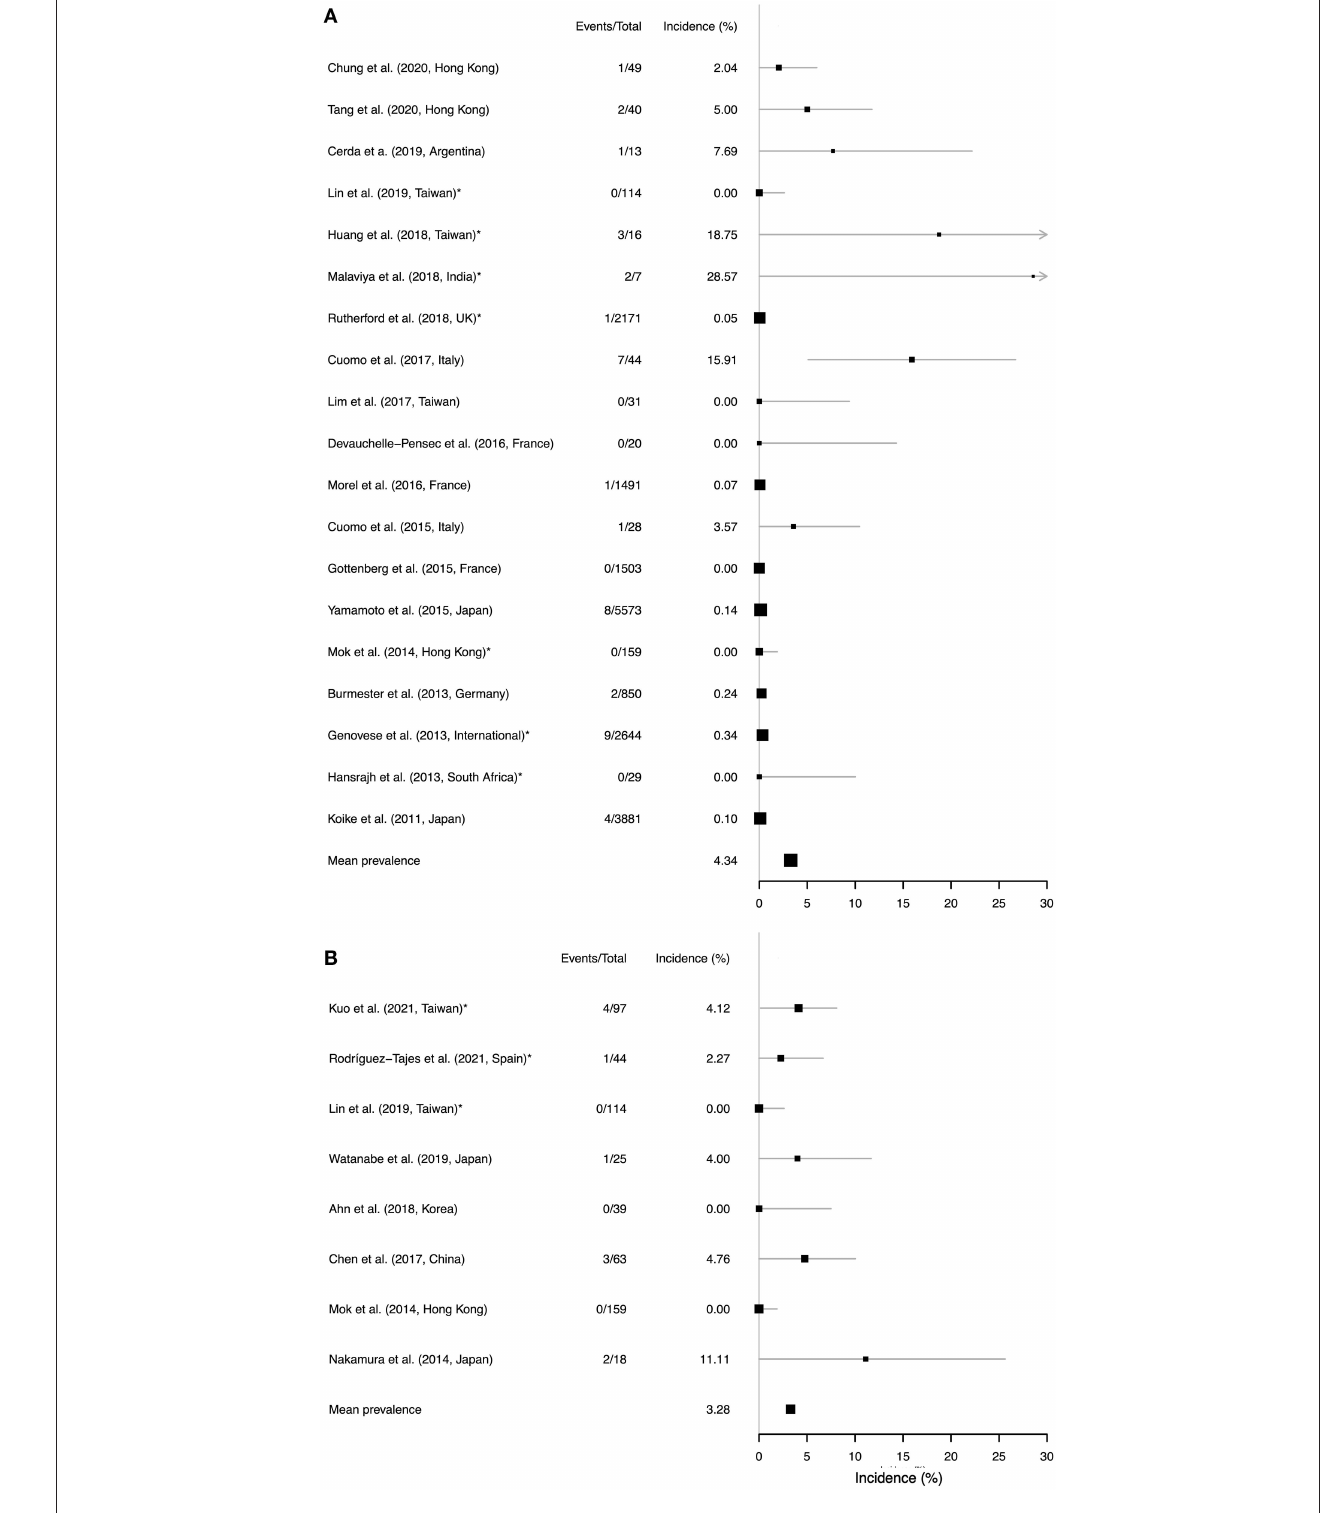
FIGURE 4 | Forest plots to show data from a systematic literature review to identify studies reporting a risk of reactivation of (A) TB and (B) HBV in individuals treated with TCZ therapy. Studies are ranked in order of follow-up duration. Location of the study is presented for each study, as the baseline prevalence of TB and